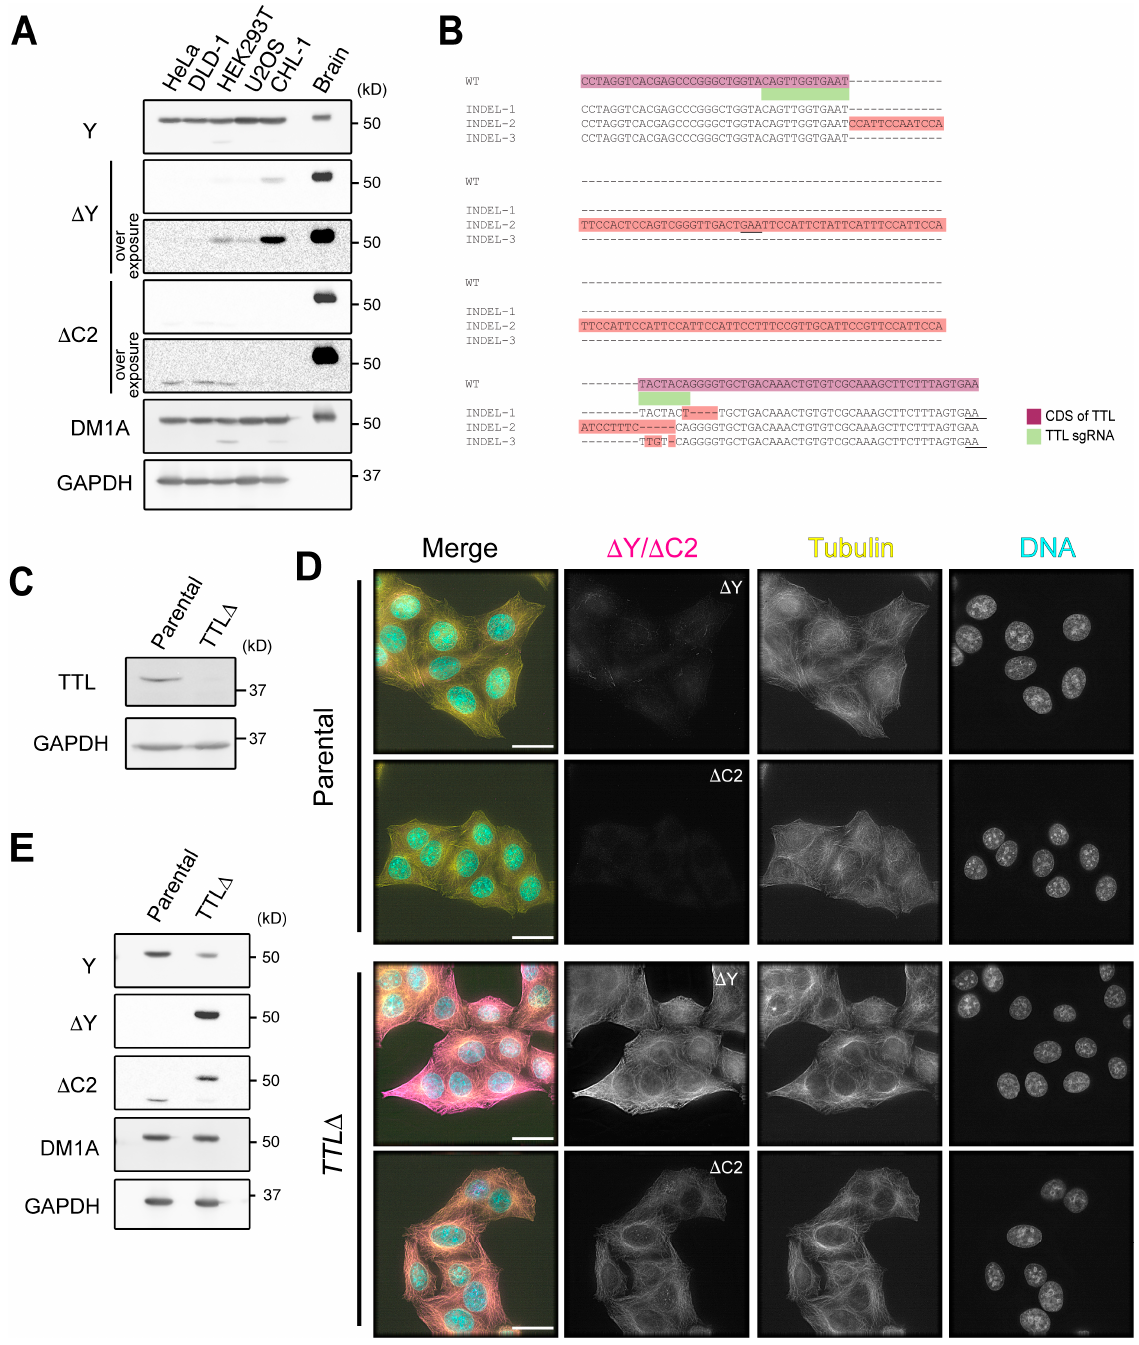
Figure 1. ∆ C2- α -tubulin levels increase in TTL ∆ HeLa cells. ( A ) Immunoblotting of whole cell lysates prepared from various tissue culture cell lines. ∆ C2- α -tubulin was virtually undetectable. ( B ) Detection of CRISPR/Cas9-induced INDELs in the TTL ∆ line (clone 1). Three independent INDELs, all of which resulted in early stop codons (underlined), were identified. ( C ) Immunoblotting of whole cell lysates prepared from the parental HeLa and TTL ∆ lines. ( D , E ) Detection of ∆ Y- and ∆ C2- α -tubulin in the TTL ∆ line by immunofluorescence ( D ) and immunoblotting in cell lysates ( E ). In merged images in ( D ), ∆ Y- or ∆ C2- α -tubulin is shown in magenta, total α -tubulin (DM1A staining) in yellow, and DNA (DAPI staining) in cyan. Scale bars in ( D ), 25 µ m. We treated cell lines that harbor varying levels of ∆ Y- α -tubulin (HeLa, DLD-1, CHL-1, and TTL ∆ ) with 10 µ M taxol for 12 h and then processed them for